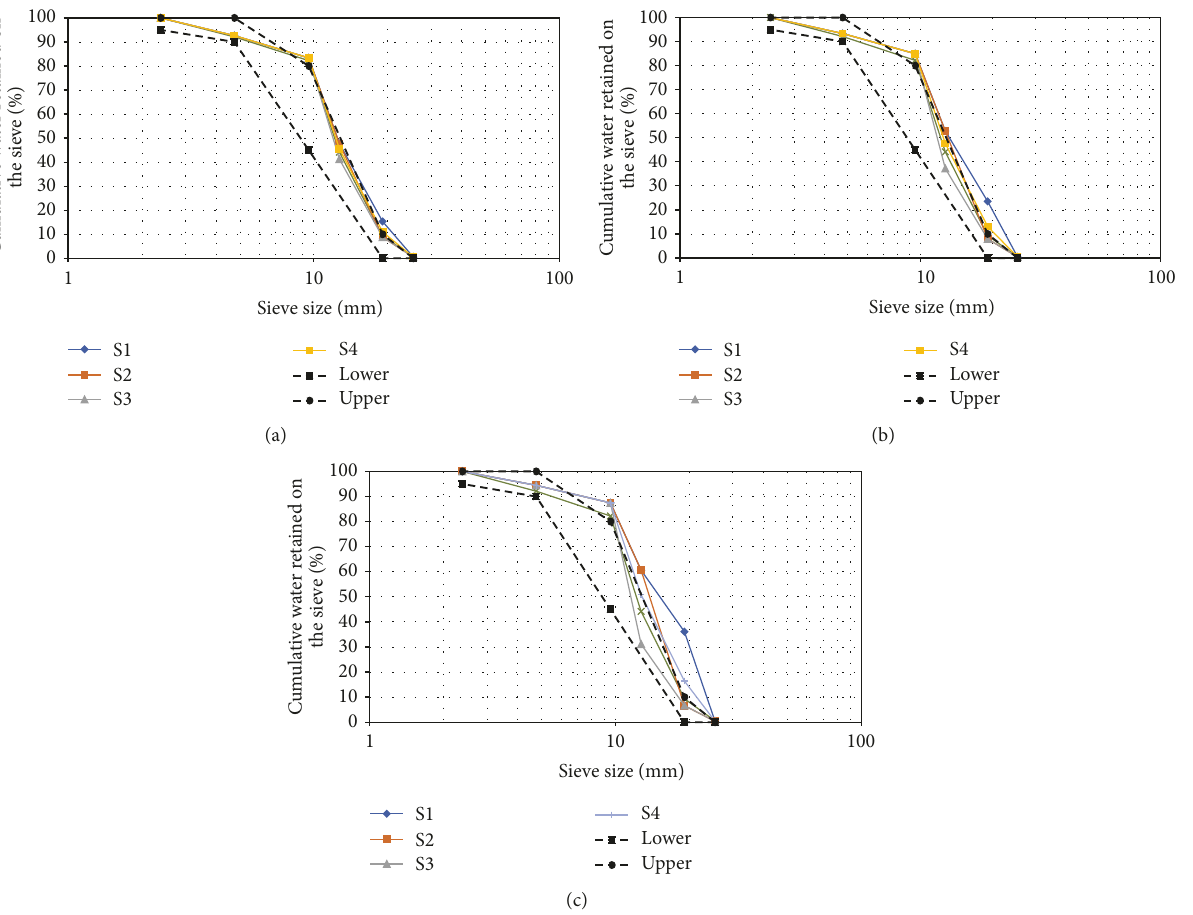
Figure 4: Size distribution of AAC-LWA of (a) LWA20, (b) LWA40, and (c) LWA60 in accordance with ASTM C33 Size Number 67. The green curve refers to the normal weight coarse aggregates (NWCA) (as shown in Figure 3), for comparison to S1–S4.